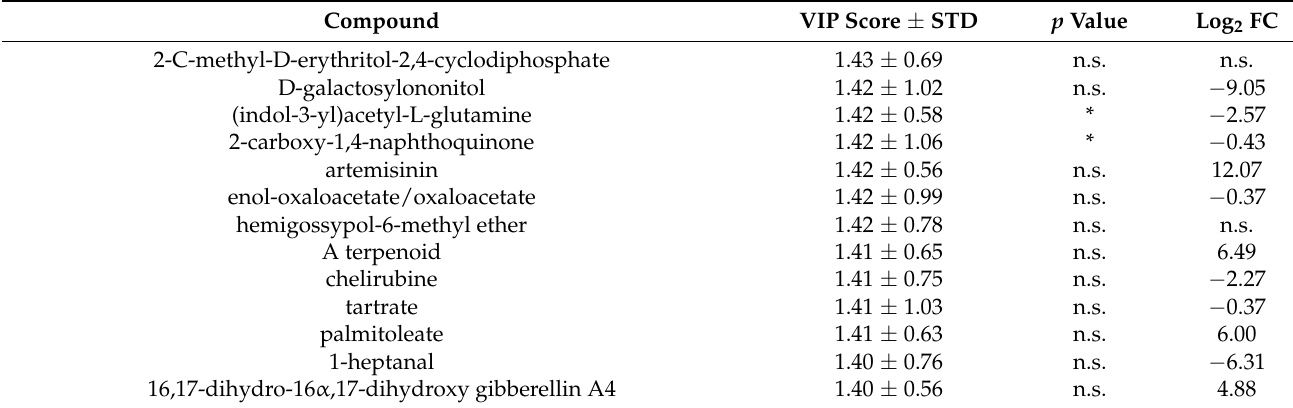
Table 1. Cont. Compound